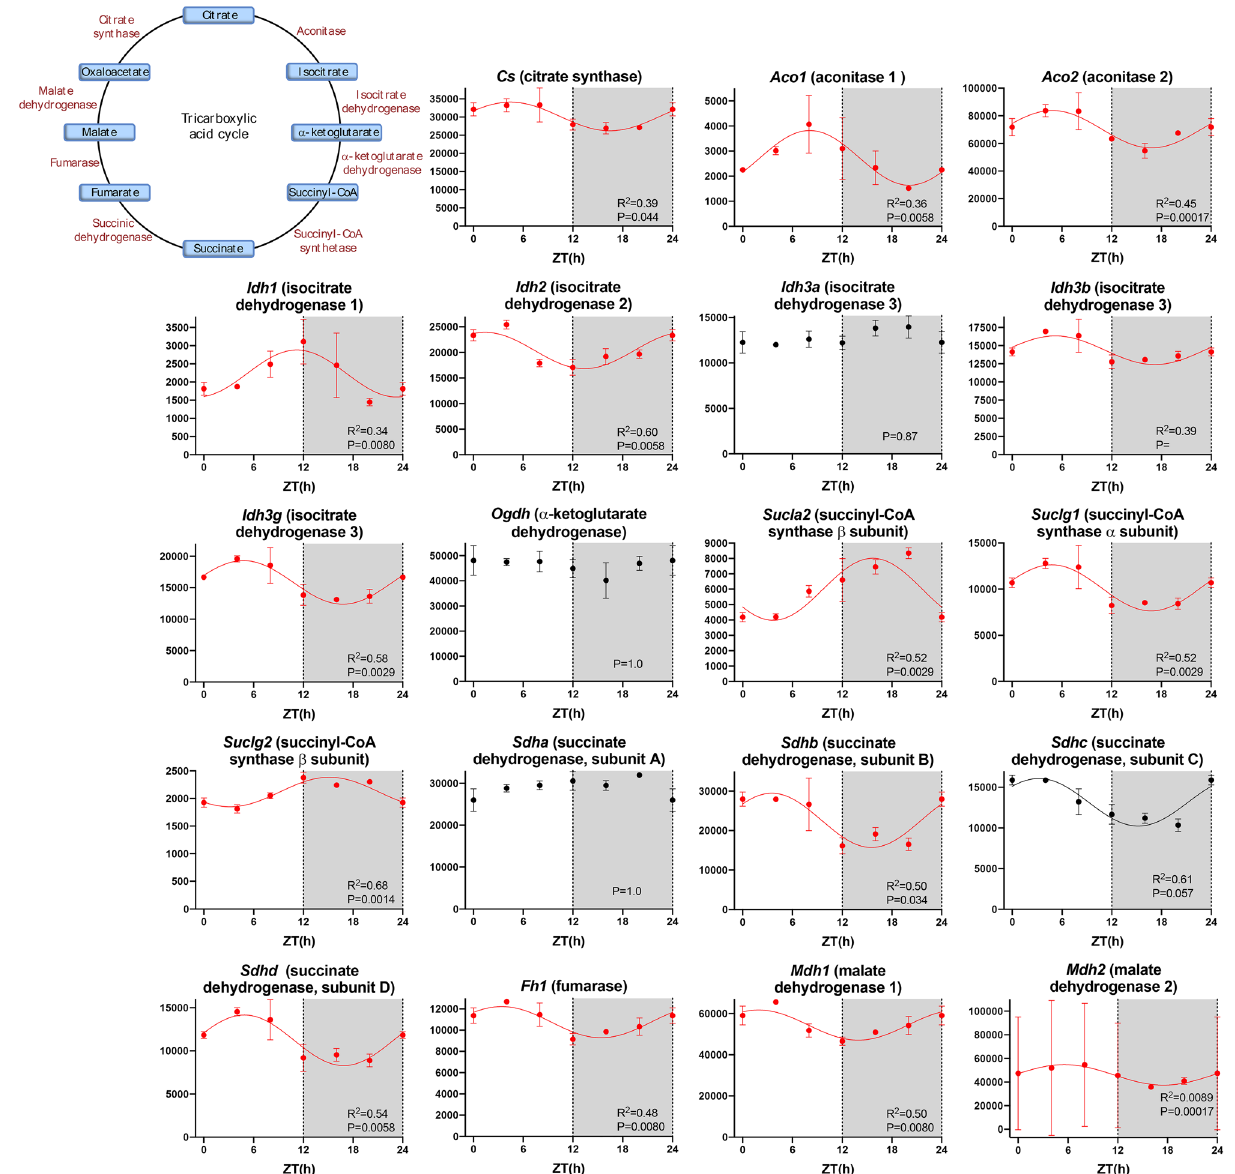
Figure 5. Citric acid cycle. Abundance (normalised counts) of citric acid cycle transcripts is shown over 24 h. The inset shows a schematic diagram of the citric acid cycle. See Fig. 1 legend for further